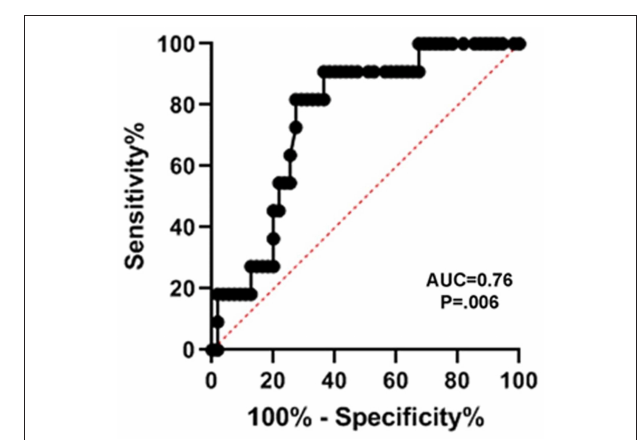
FIGURE 4 | Serum SNTF on the day of mTBI predicts persisting dysfunction in sensory-motor integration at 90 days post-injury. Serum SNTF levels were analyzed for each participant a minimum of 4 times, and evaluated in relation to sensory-motor performance scores by Mann-Whitney U test. Sensory-motor integration function was assessed at 90 days post-injury by the Grooved Pegboard test ( n = 65). Criteria for poor test performance were either a slow dominant hand speed to complete the test of > 80s or commission of two or more dominant hand errors. Seventeen percent of the mTBI cases met these criteria for dysfunctional sensory-motor integration at 90 days. In ROC-AUC analyses, SNTF distinguished cases with impaired sensory-motor integration at 90 days from those not meeting criteria for long-lasting dysfunction (AUC = 0.76, p = 0.006).